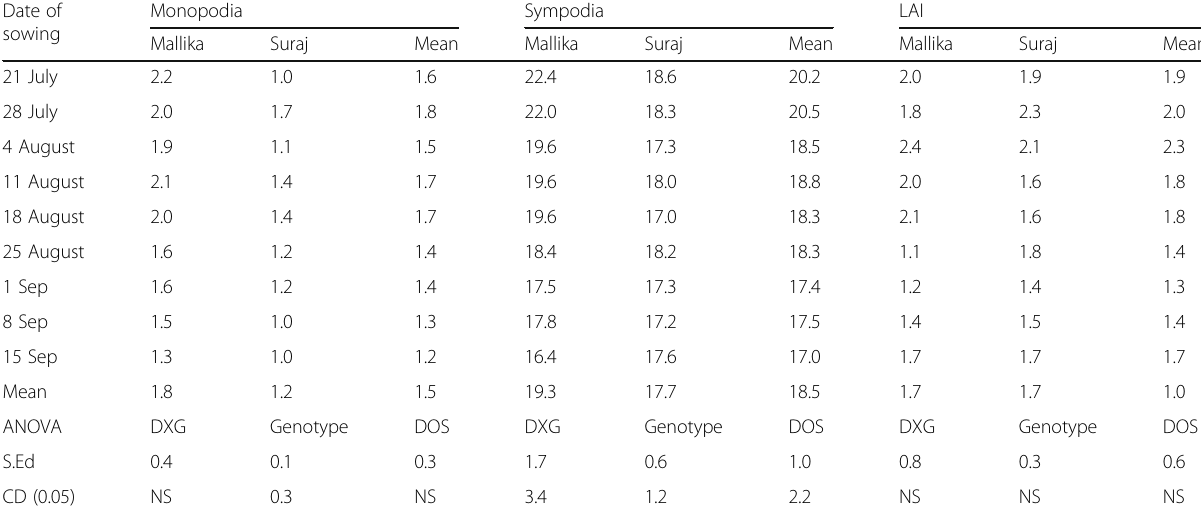
Table 3 Growth characters as influenced by genotypes and date of sowing at harvest Date of Monopodia Sympodia sowing